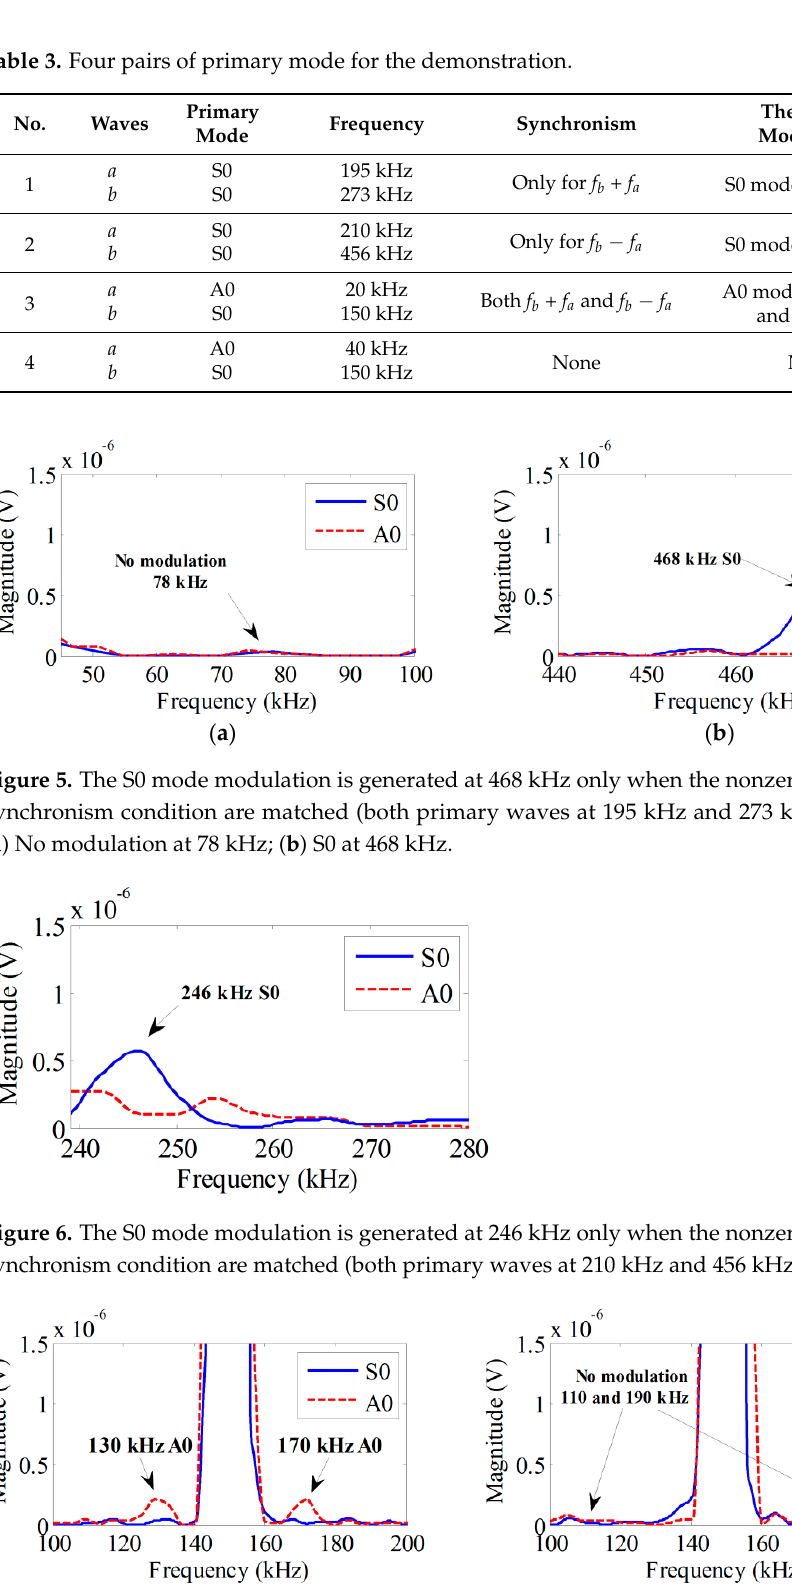
Figure 7. The A0 mode modulation is generated at both 130 kHz and 170 kHz from 20 kHz A0 mode and 150 kHz S0 mode, as shown in ( a ), while no modulation is generated from 40 kHz A0 mode and 150 kHz S0 mode when the synchronism condition is not matched as shown in ( b ): ( a ) S0 at 130 kHz and 170 kHz; ( b ) A0 at 130 kHz and 170 kHz.